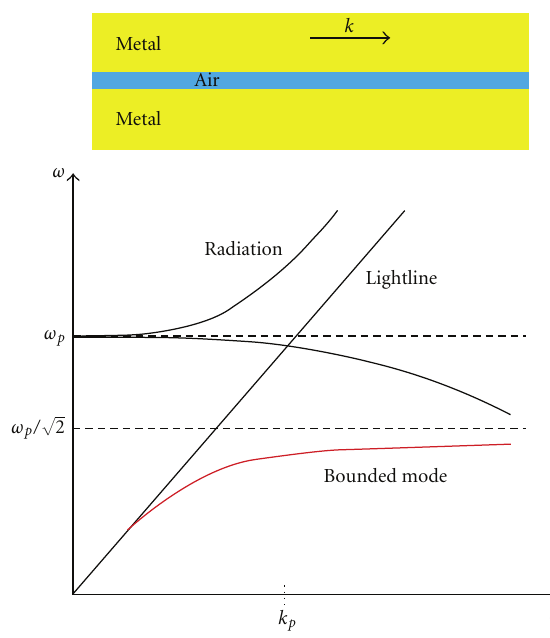
Figure 6: Dispersion plot for the MIM-layered structure adapted from